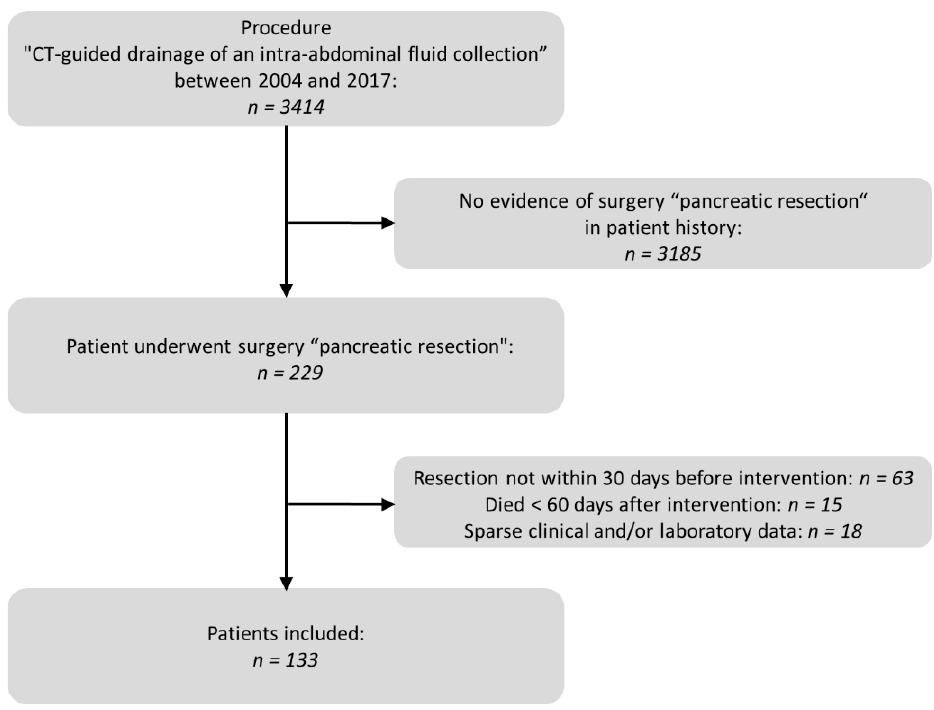
Figure 1. Patient selection process flow chart.